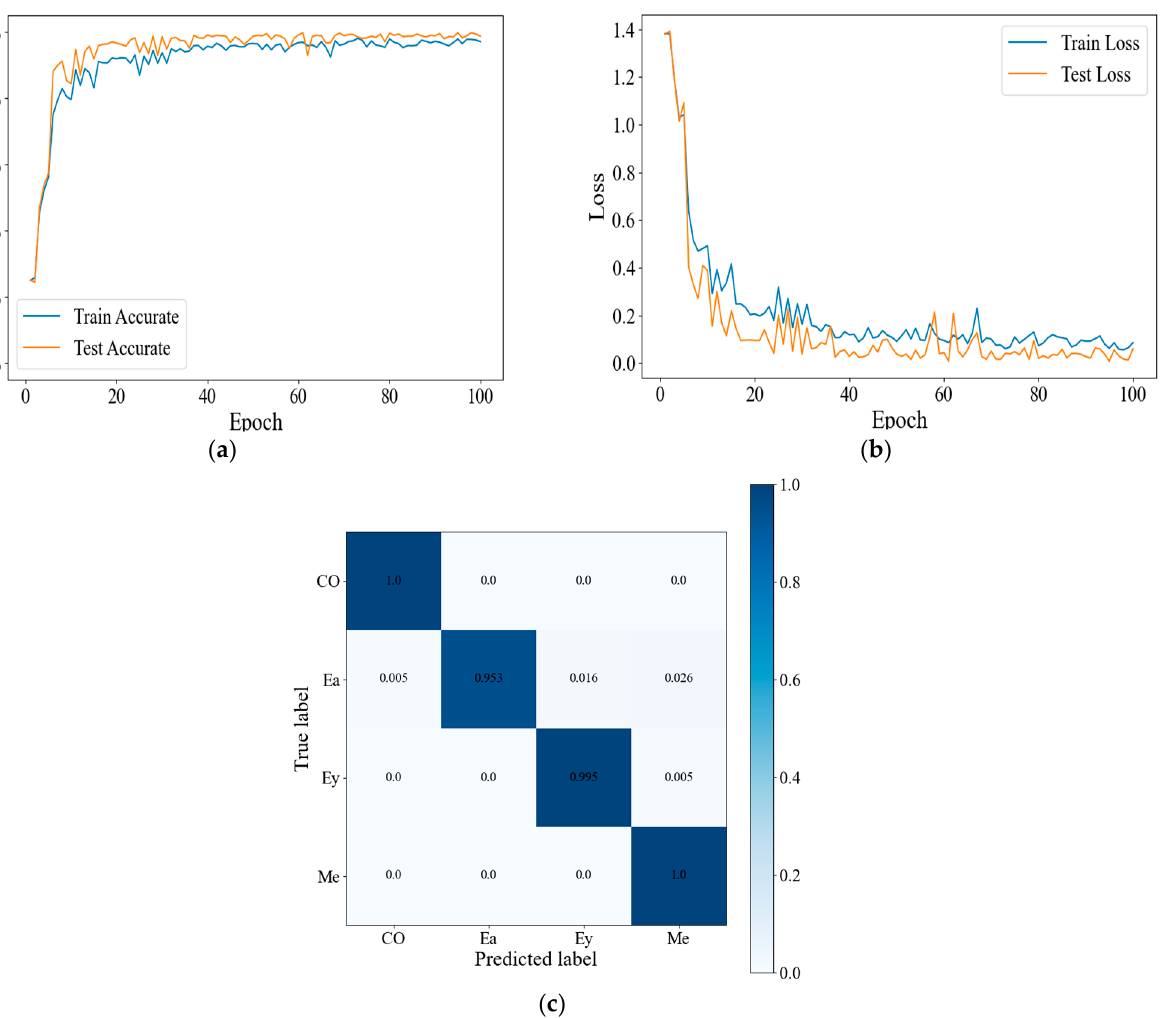
Figure 12. ( a ) The training and test accuracy curves in basic experiment. ( b ) The training and test loss curves in basic experiment. ( c ) Confusion matrix of basic experiment.